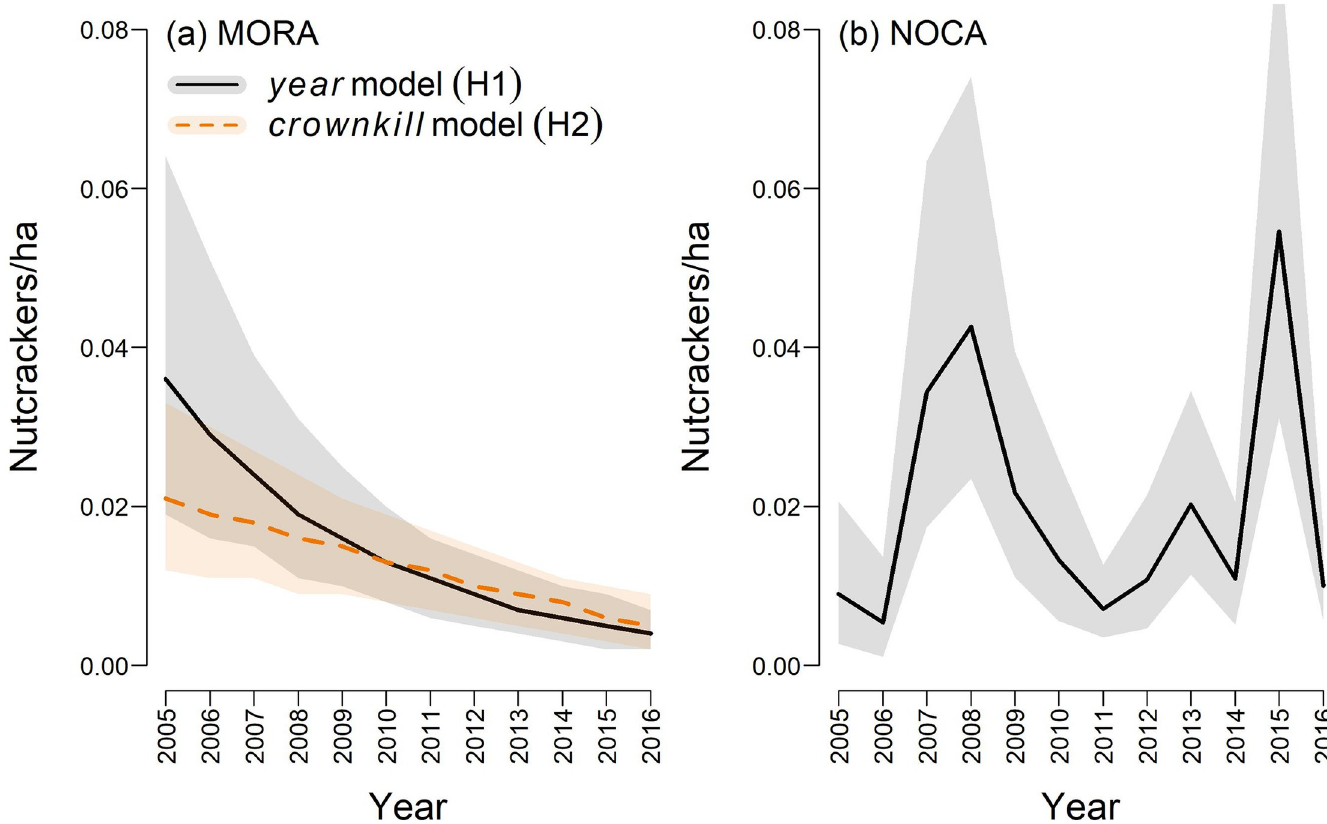
Fig 6. Modeled estimates of Clark’s nutcracker density in Mount Rainier National Park (MORA) and North Cascades National Park Service Complex (NOCA). Annual estimates were based on models without (solid black curve) or with (dashed orange curve) an effect of whitebark crownkill on nutcrackers per hectare. Because most (81/82) nutcracker detections in MORA occurred within high-elevation transects, we did not extrapolate densities to lower elevations in that park. In NOCA, nutcracker density was estimated across all elevational strata, but was unrelated to whitebark trends (Fig 5). Shaded regions represent 95% credible intervals on nutcracker density in each